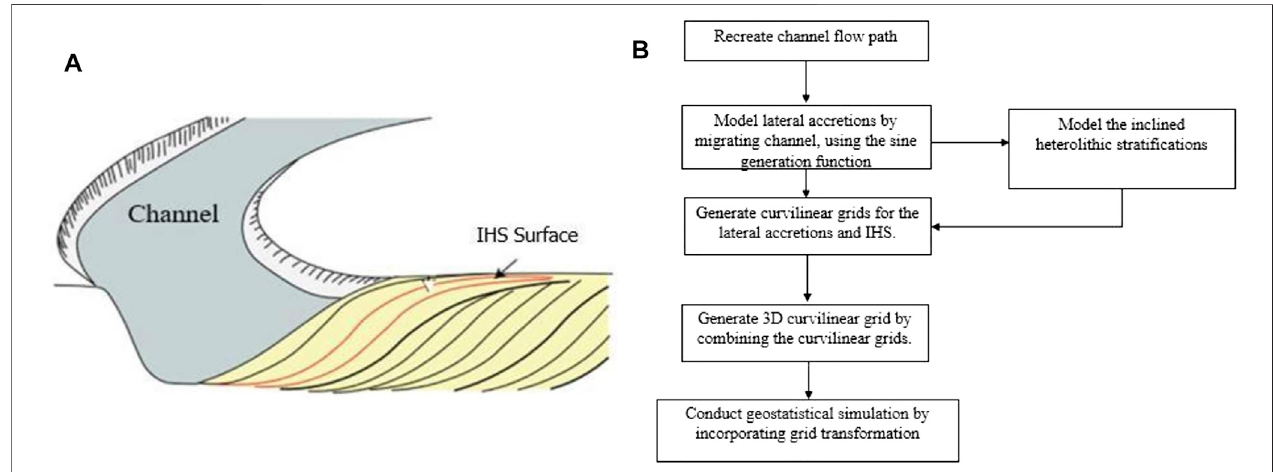
FIGURE 1 | (A) point bar schematic showing laterally accreating sigmoidal inclined heterolithic surfaces, as adapted from (McMahon and Davies, 2018), and (B) work fl ow for modeling point bar reservoir geometry and petrophysical properties.